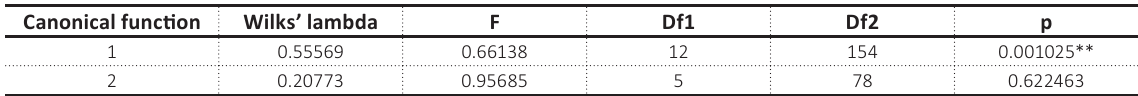
Table 4. Canonical dimensions (the financial sector) Canonical function